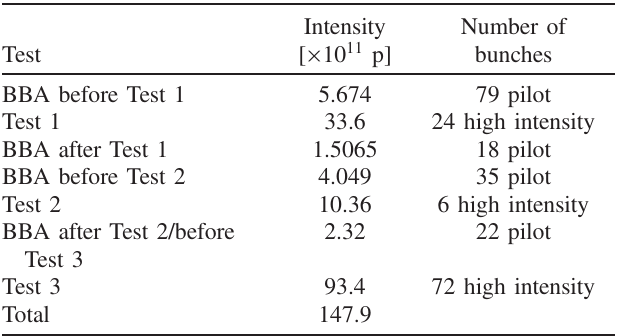
TABLE IV. Sequence of the tests. Tests 2 and 3 were carried out on a different day than Test 1. The intensity of pilot and high- intensity bunches is on the order of 10 9 and 10 11 protons, respectively.